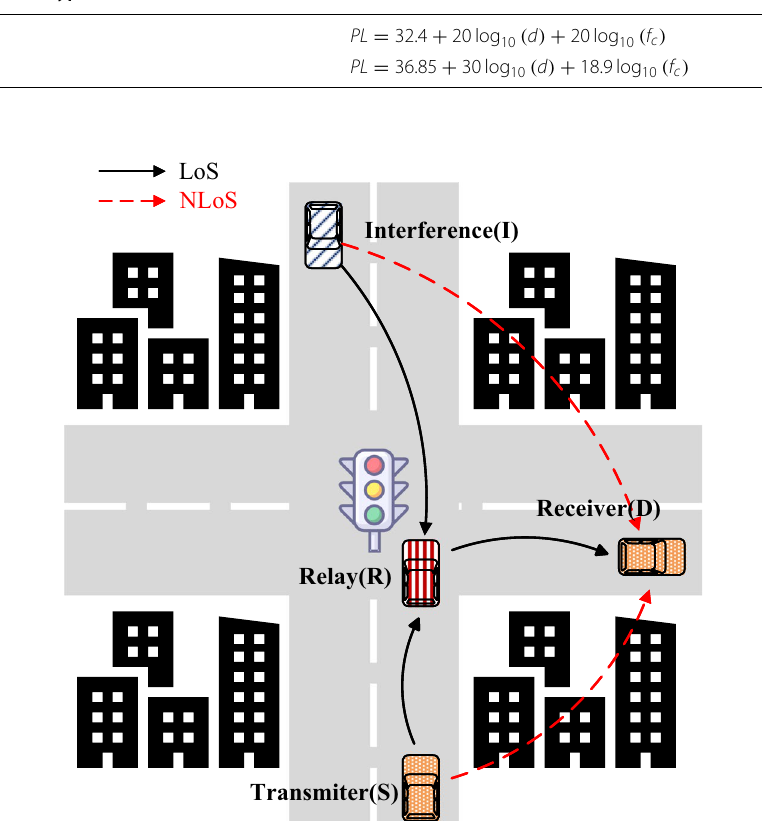
Fig. 4 Sketch map of V2X communication at the